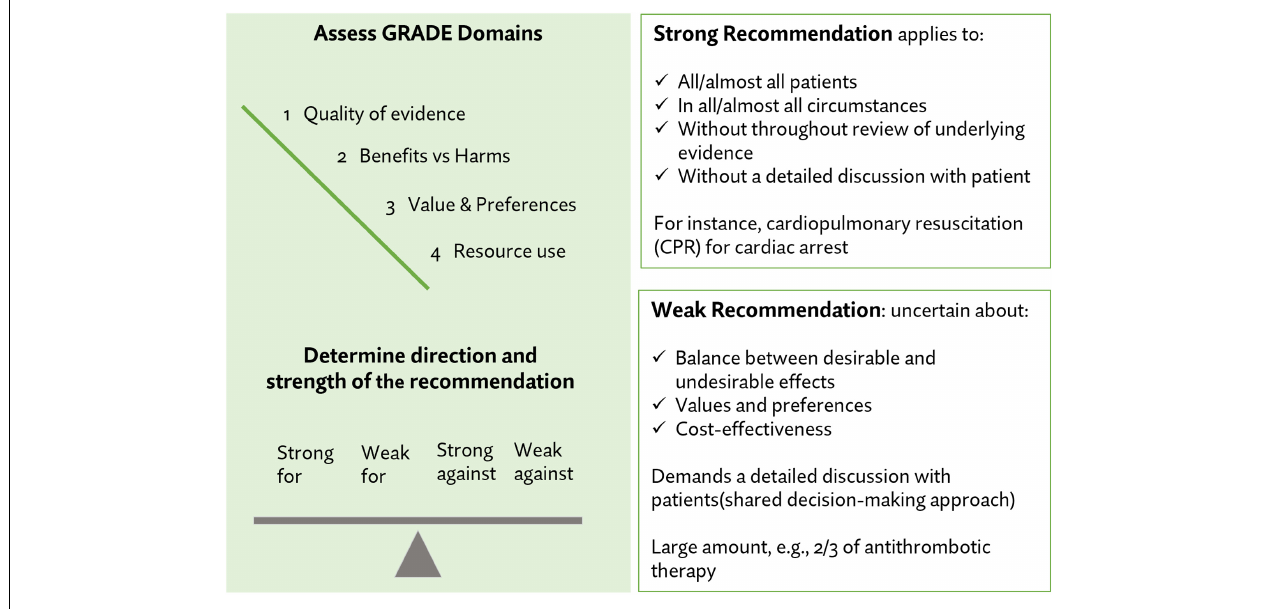
FIGURE 1 | Strength and quality assessments for individual recommendations (Guyatt et al.,